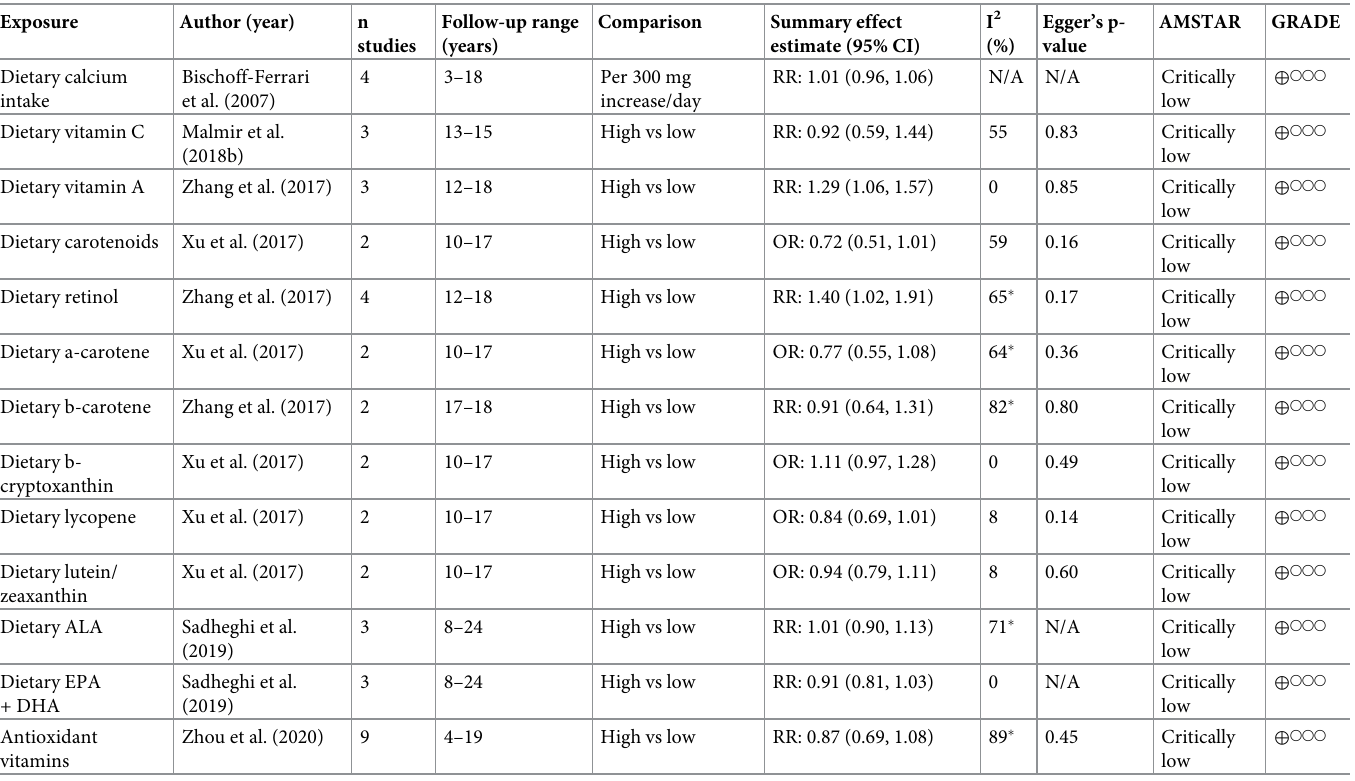
Dietary patterns. Table 1 shows the findings and the quality of evidence for associations between adherence to dietary patterns and the incidence of hip fracture. An inverse linear Table 4. Summary characteristics and findings of meta-analyses of cohort studies assessing associations between dietary intake of micronutrients and hip fracture risk.